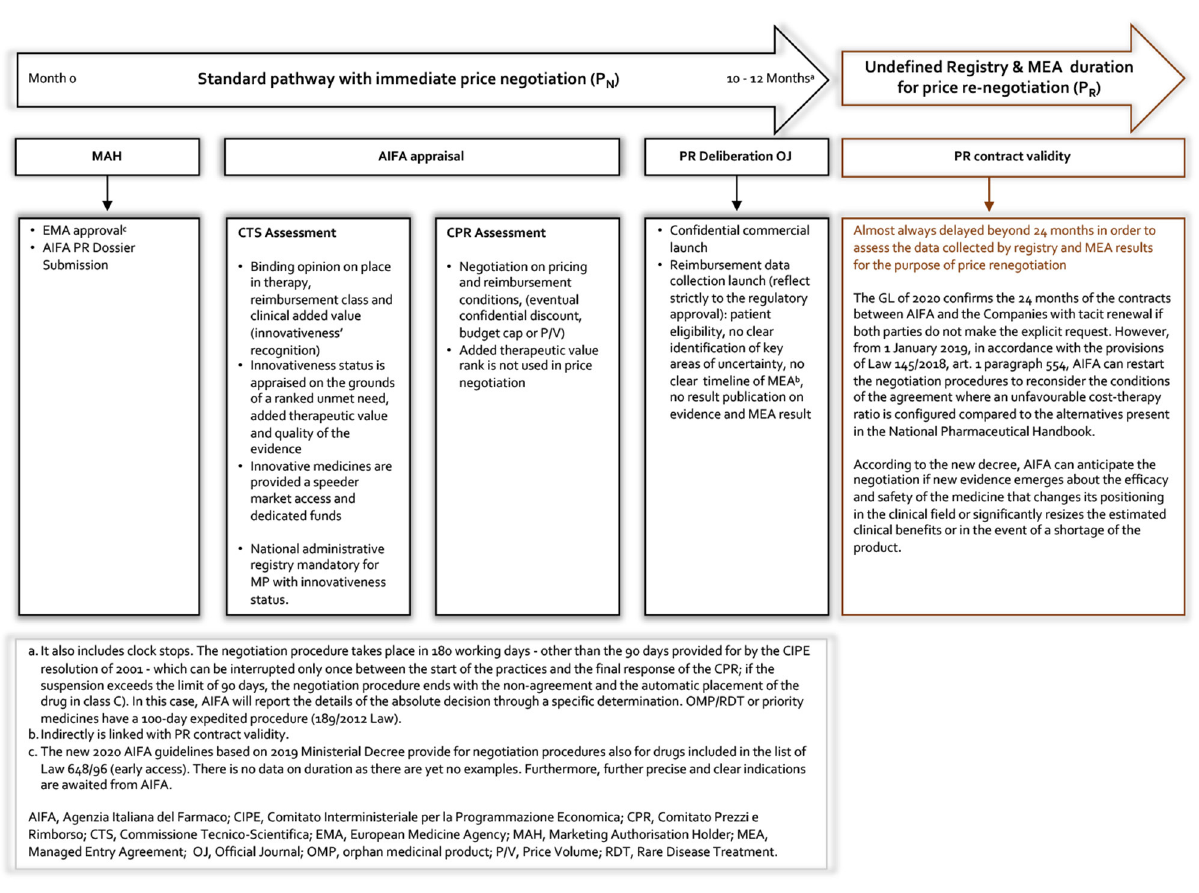
FIGURE 3 | Current AIFA MEA registry